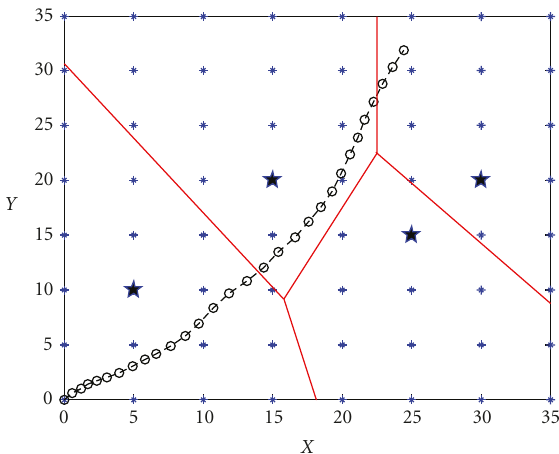
Figure 4: The typical tracking scenario under discussion, where the blue stars are the uniformly deployed nodes, the pentagrams are the cluster heads, and the dashed crossed black circles are the true target trace. x -axis unit: meter; y -axis unit: